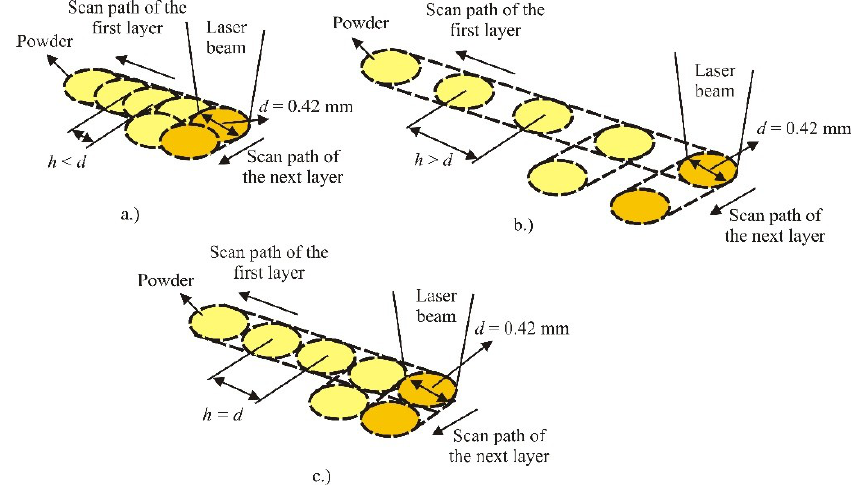
Figure 3. Scanning paths for sintering: ( a ) h < d , ( b ) h > d and ( c ) h = d [20].